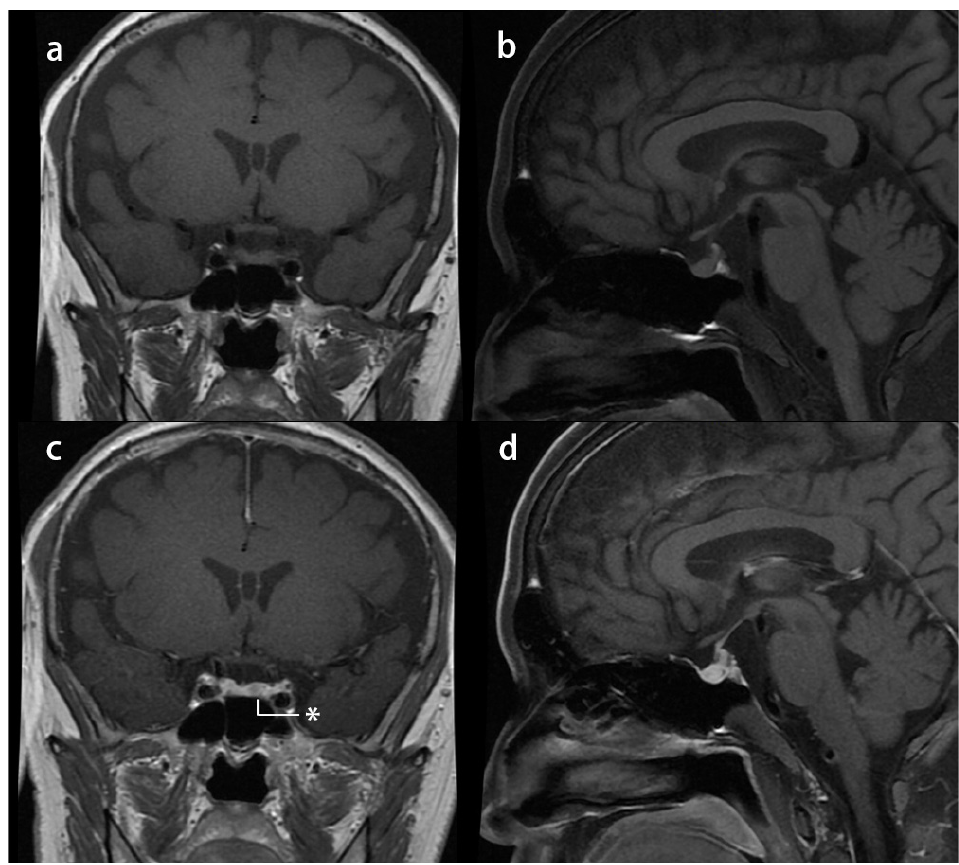
Figure 3. Presurgical pituitary MRI study of case 2: ( a ) T1-weighted image (T1-WI) coronal plane and ( b ) T1-WI sagittal plane showing a normal pituitary stalk without any nodule; ( c ) T1-WI contrast-enhanced coronal plane reveals a hypointense nodule* in the left side of the pituitary gland; and ( d ) T1-WI contrast-enhanced sagittal plane.